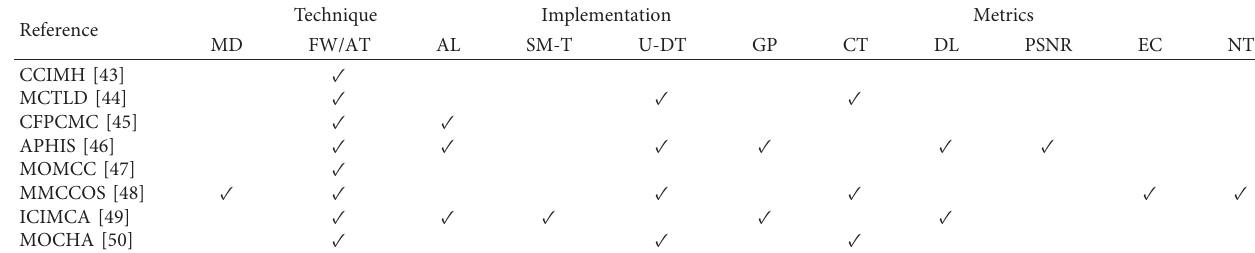
Table 9: Analysis of application development techniques in MCC.